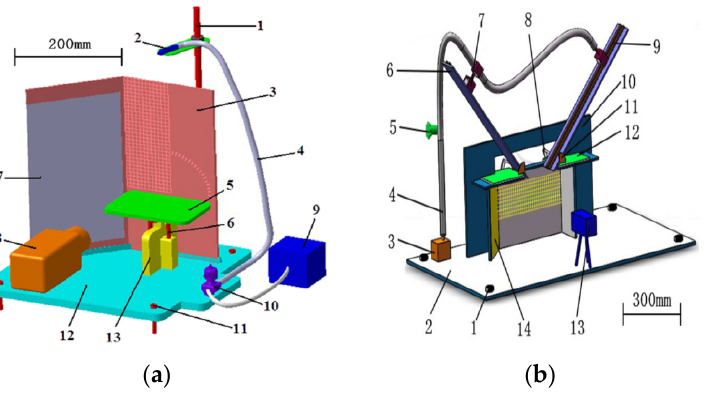
Figure 10. The device for measuring the coefficient of restitution by the drop method and the particle collision method. ( a ) Drop method; ( b ) Particle collision method [102].